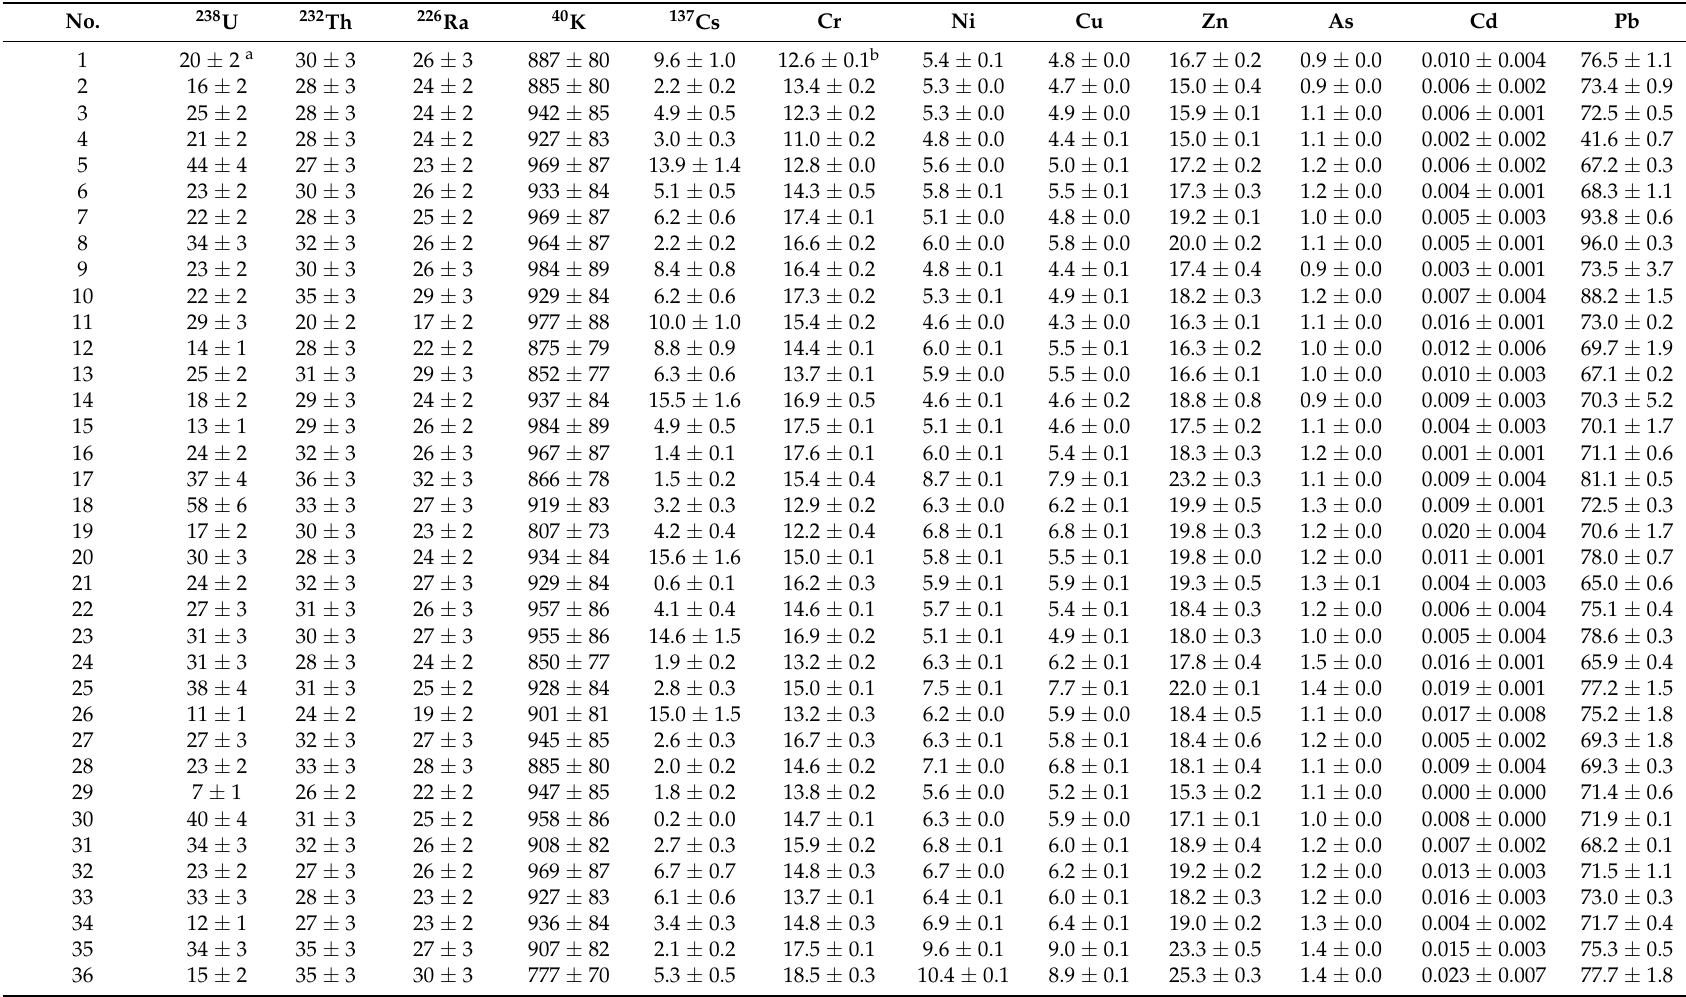
Table 2. The contents of radionuclides (Bq/kg) and heavy metals (mg/kg) in surface soil samples around the Bayanwula prospective uranium mining